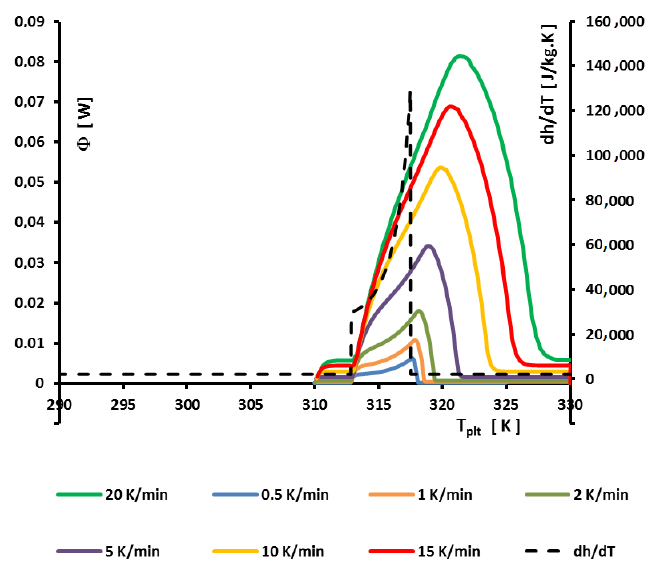
d h for a solution at x 0 = 0.8; from d T